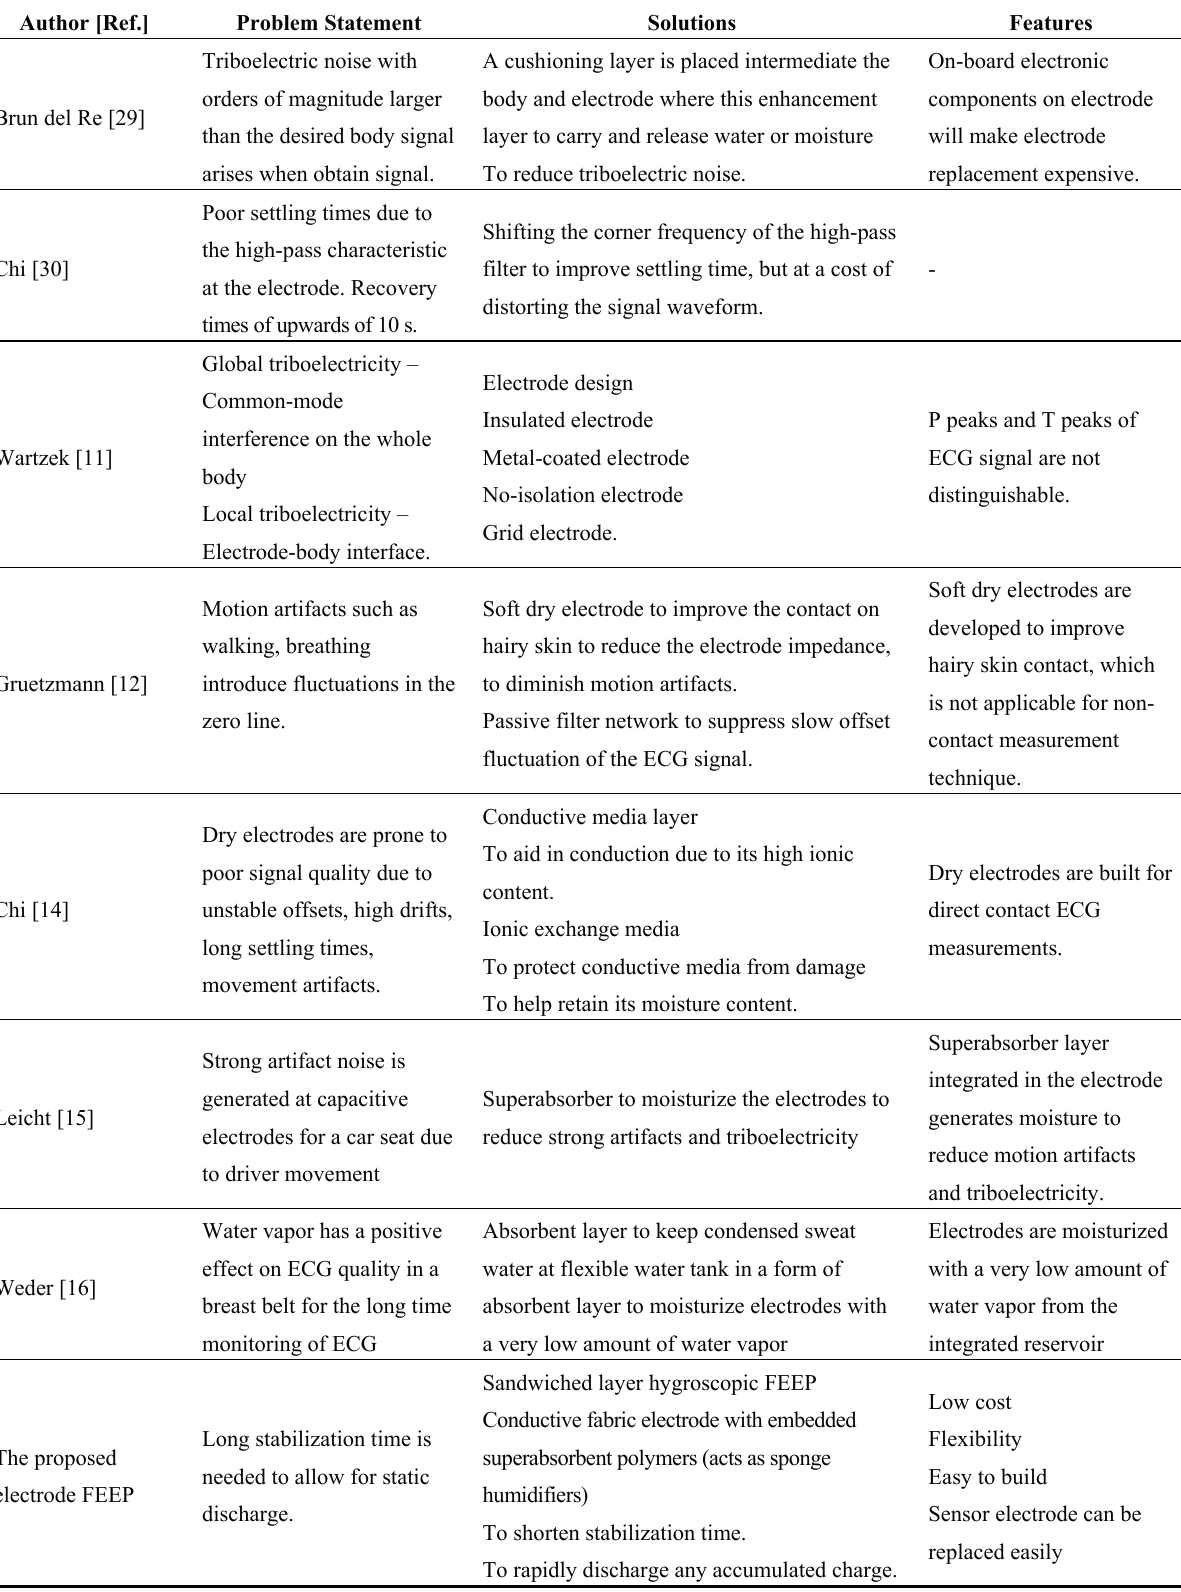
Table 2. Overview of existing sensor